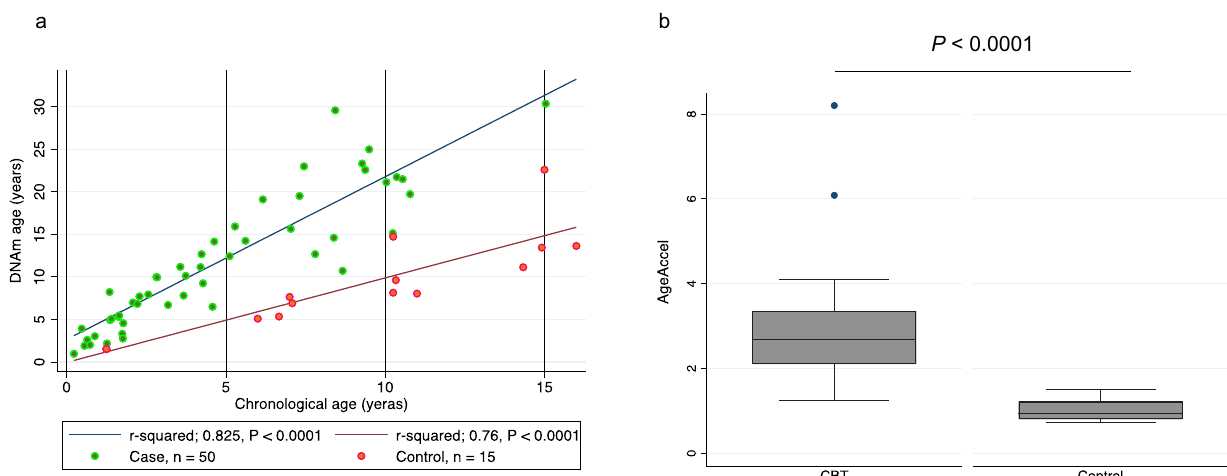
Figure 1. Comparison of DNAm age and chronological age in cases and controls. ( a ) While the control matched the chronological age on the horizontal axis and the DNAm age on the vertical axis, the DNAm age was higher than the chronological age in the donor after cord blood transplantation. There was a strong correlation between chronological age and DNAm age in both control and cord blood transplant cases. ( b ) The mean of AgeAccel in controls (mean; 1.01, 95% CI, 0.88–1.14) was significantly lower than cord blood transplant cases (mean; 2.84, 95% CI, 2.51–3.17) ( t -test, P < 0.001).